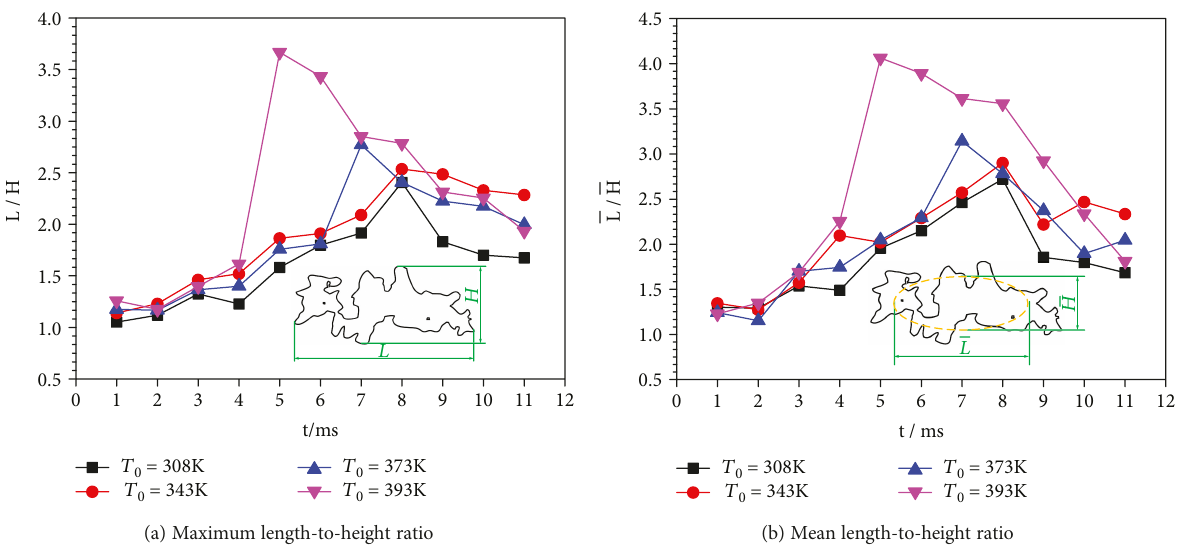
Figure 9: Length-to-height ratio at fl ame development process.